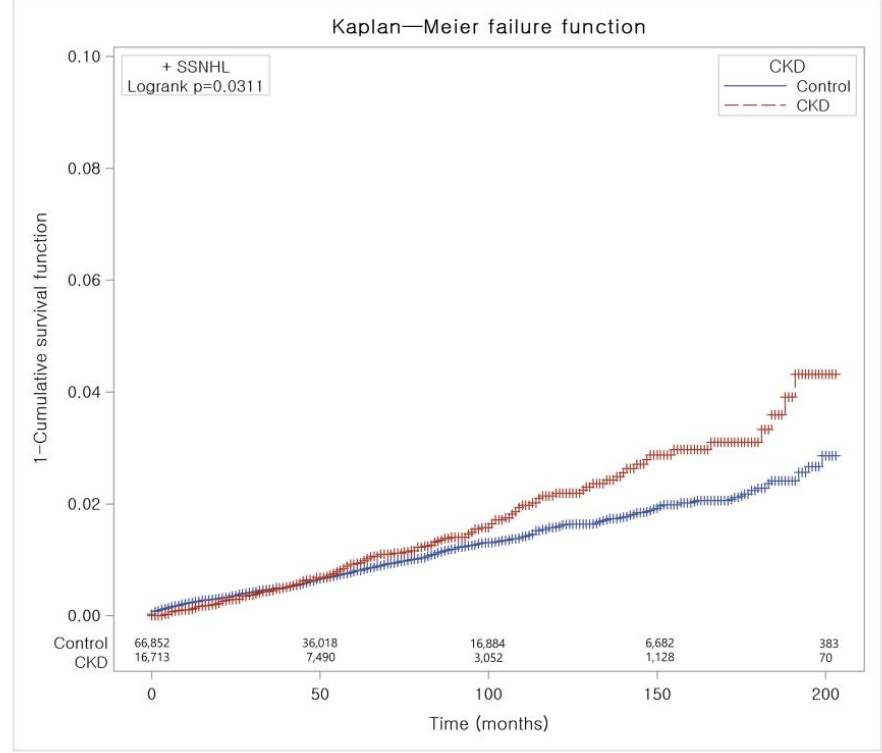
Figure 2. Risk of development of SSNHL among individuals with and without CKD. Abbreviation: SSNHL, sudden sensorineural hearing loss; CKD, chronic kidney disease.